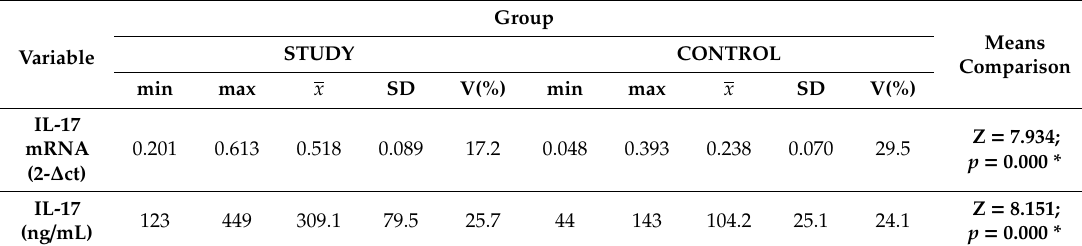
Table 2. Interleukin 17 expression in studied groups.